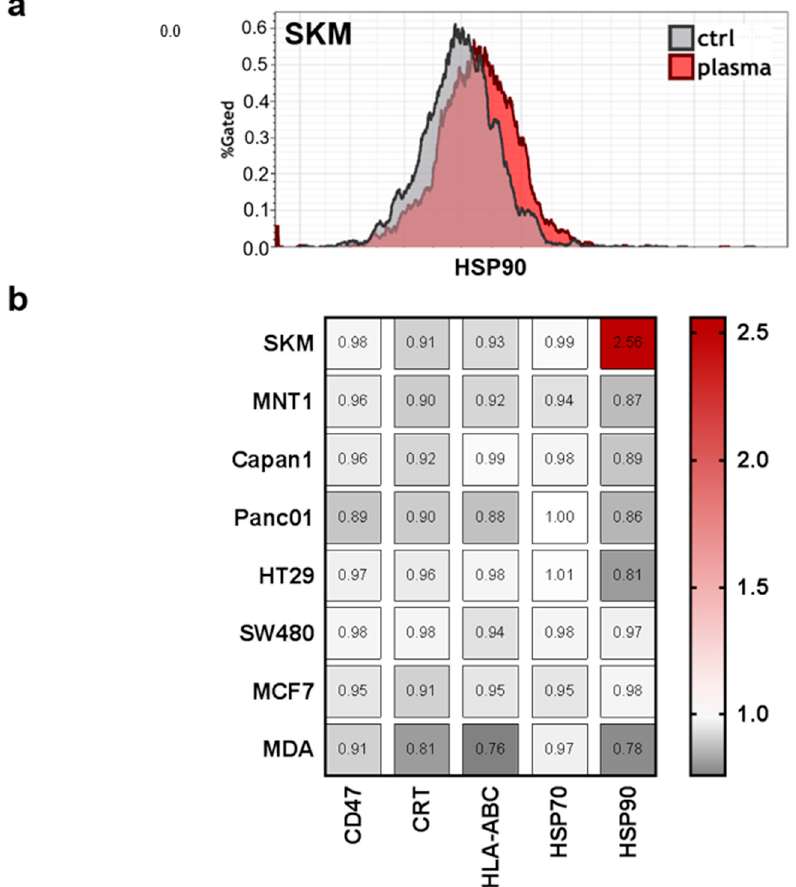
Figure 6. Expression of immune-response relevant surface markers remains predominantly unchanged after plasma treatment. Cells were harvested, stained with anti-cluster of differentiation 47 (CD47, PerCP-Cy5.5), anti-calreticulin (CRT, AF647), anti-human leucocyte antigen ABC (HLA-ABC, PE-Cy), anti-heat-shock protein 70 (HSP70, AF488), and anti-heat-shock protein 90 (HSP90, AF700) and were measured by flow-cytometry. ( a ) Representative overlay of expression of HSP90 in SKM28 cells; ( b ) quantification of mean fluorescence intensities (MFIs) on viable cells normalized on each’s cell lines untreated medium control.